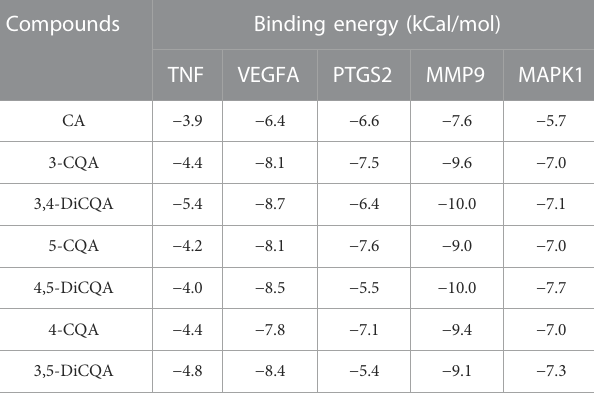
TABLE 9 Results from molecular docking.